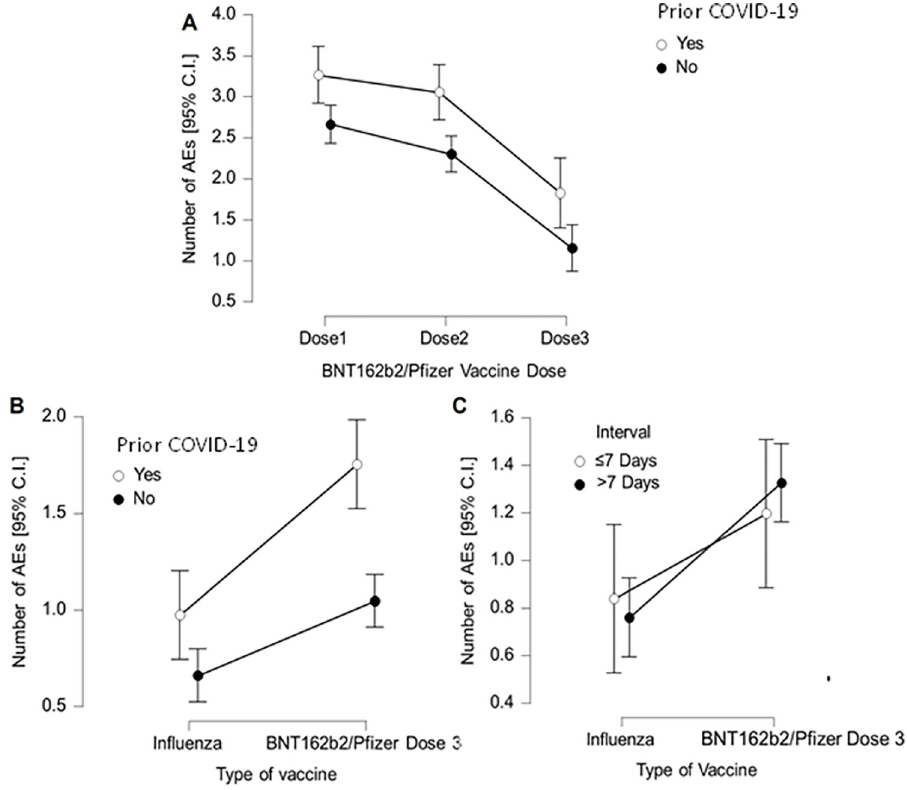
Fig 1. Frequency of AEs by vaccine type, prior COVID-19 status and interval between doses. A. Number of AEs according to previous COVID-19 history, for all three BNT162b2/Pfizer doses. B. Number of AEs according to previous COVID-19 history for BNT162b2/Pfizer third/booster dose and the seasonal influenza vaccine. C. Number of AEs according associated with the influenza vaccine versus BNT162b2/Pfizer third/booster dose for those HCWs who had these vaccines � or > 7 days